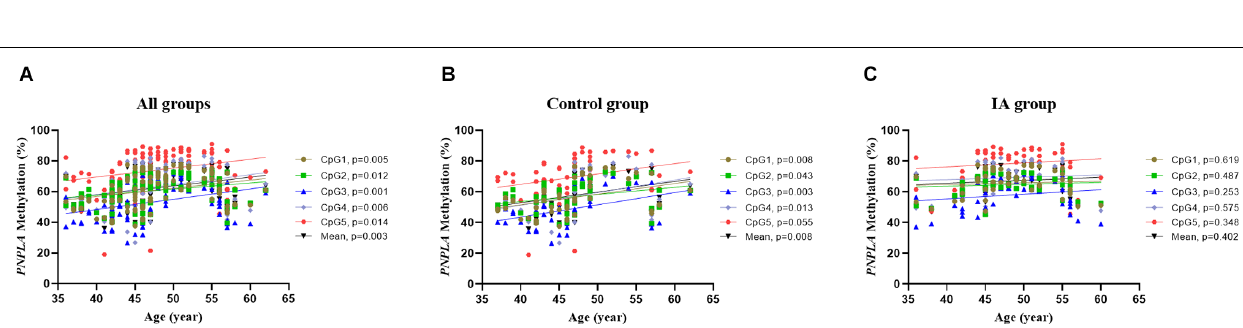
FIGURE 4 | The relationship between PNPLA6 methylations and age in different subgroups. (A) The relationship analysis in all participants. (B) The relationship analysis in the control group. (C) The relationship analysis in the IA